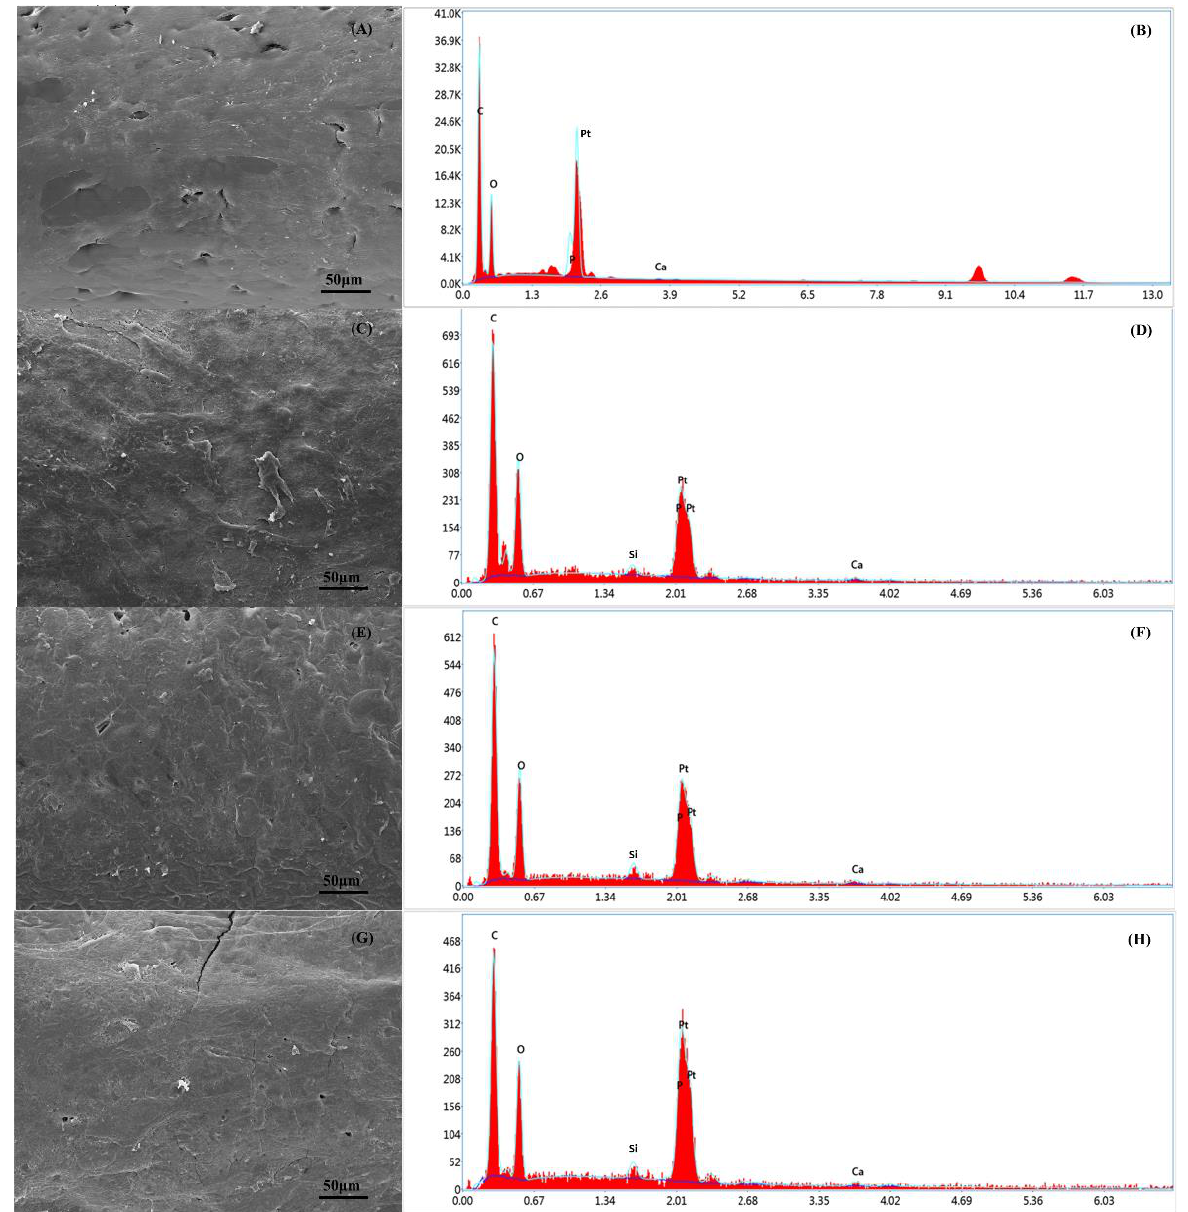
Figure 13. The SEM and EDX spectra of the scaffolds at day 14 after cell seeding: PCL scaffold ( A , B ); PCL – bioglass 10 wt% scaffold ( C , D ); PCL – bioglass 15 wt% scaffold ( E , F ); and PCL – bioglass 20 wt% scaffold ( G, H ).